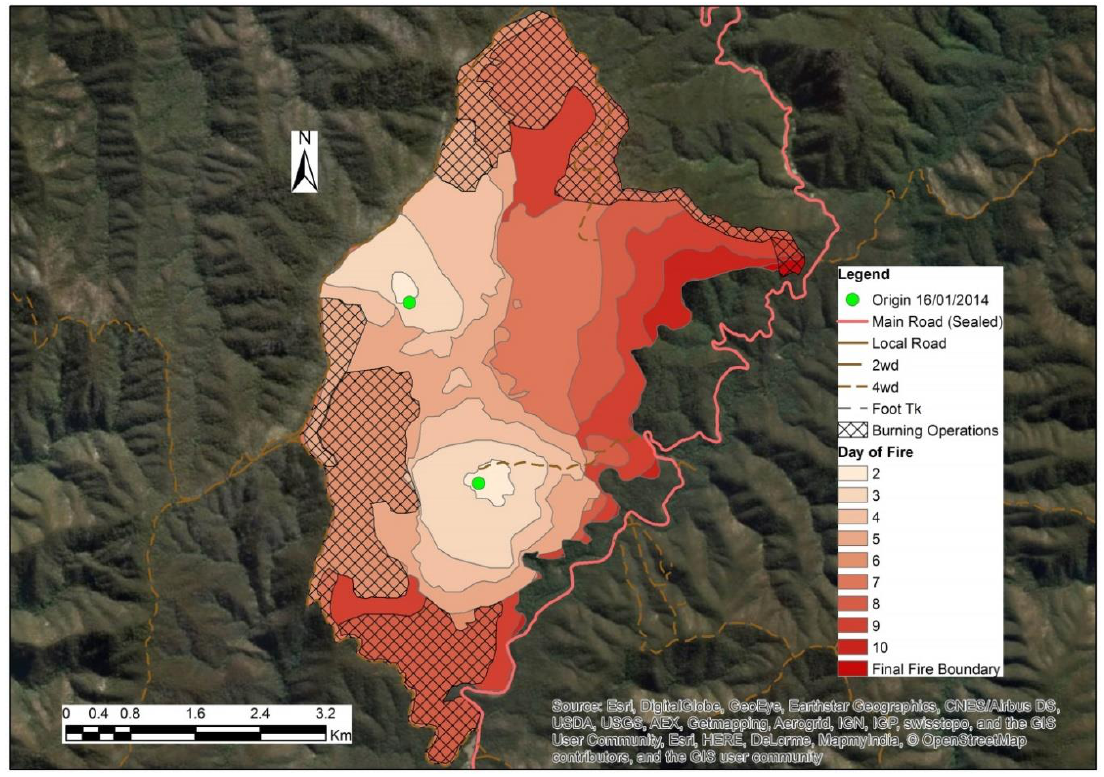
Figure A4. Corryong fire progression map.